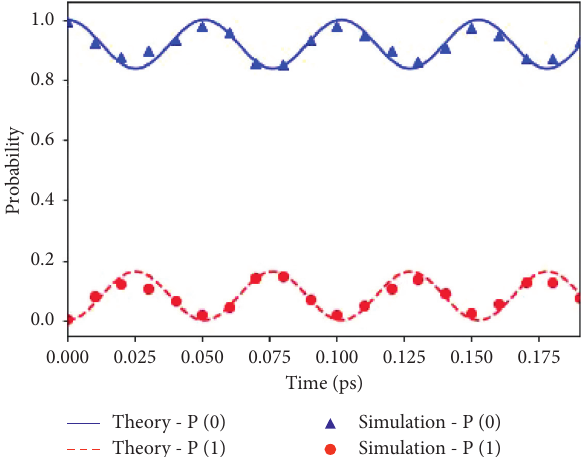
Figure 6: Evolution dynamics of the isolated system obtained by employing the quantum algorithm for the nonresonant system: simulation results (points) and theory